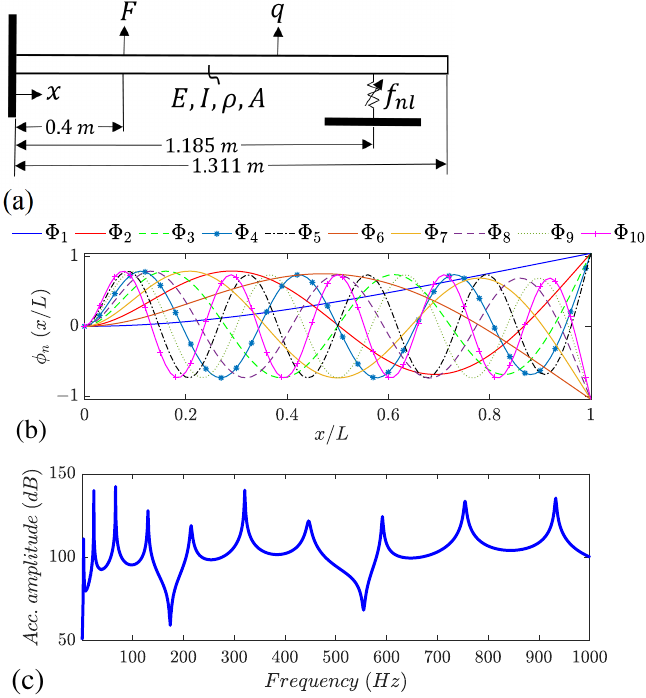
Figure 3. Cantilever beam with a nonlinear attachment benchmark ( a ) configuration, ( b ) the first ten normalized mode shape functions φ n ( x / L ) , ( c ) Amplitude spectrum of acceleration response at the tip of the